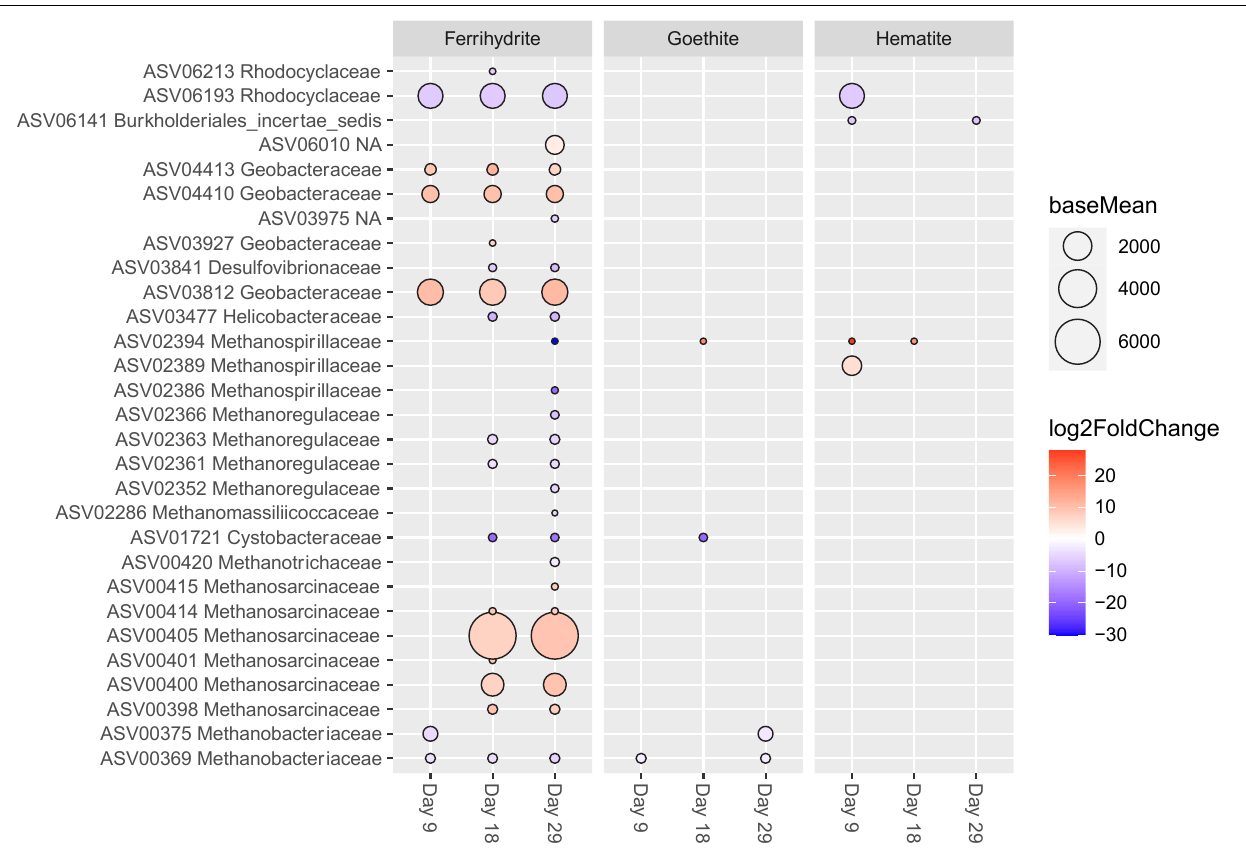
FIGURE 7 | ASVs classified as Proteobacteria and Euryarchaeota with significant (p < 0.01) log-fold changes from control experiments. Each mineral addition is compared to its time-corresponding control sample (e.g., “Ferrihydrite Day 18” vs. “Control Day 18”). The size of the circle corresponds to the normalized mean counts of each ASV, while the color corresponds to the magnitude of the log-fold